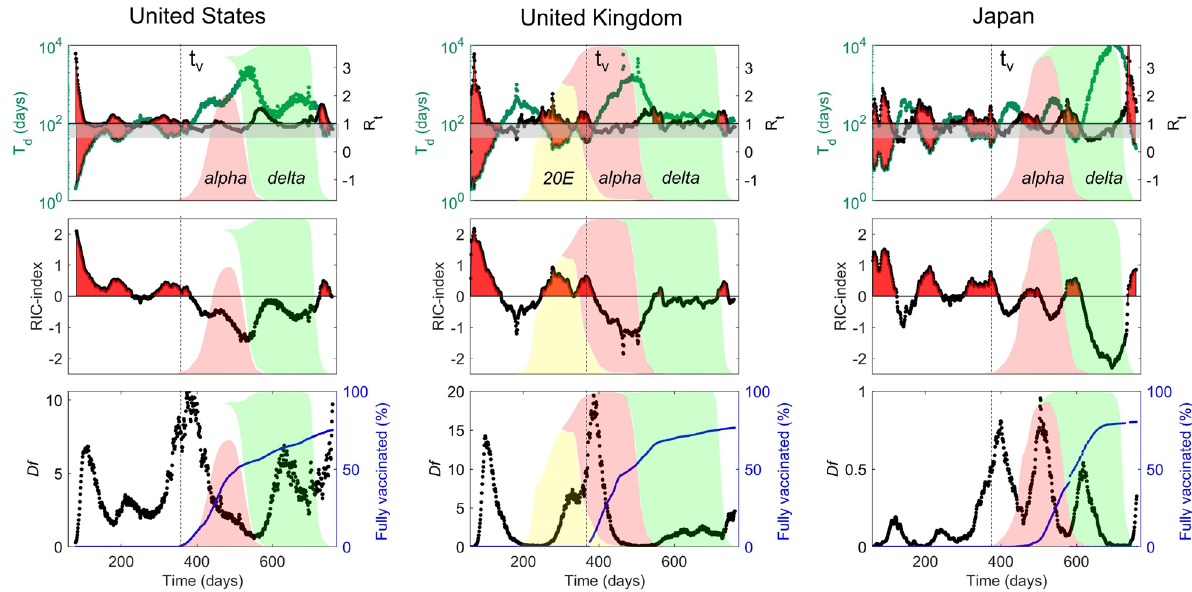
Figure 2. Epidemic spreading from 15/03/2020 to 28/01/2022 in United States, United Kingdom and Japan as described by T d , R t , RIC-index and daily fatalities per million populations ( Df ). The upper panels show plots of the time dependent doubling time 21 , T d , (green dots) and of the reproductive rate R t (black dots). The red areas are the supercritical phases that correspond to T d < 50 and R t > 1. The gray shaded stripe represents the critical crossover from the supercritical to the subcritical phase with T d > 100 and R t < 1. The three middle panels report the evolution of the RIC index where the horizontal black line separates the supercritical RIC index > 0 and the subcritical regime RIC index < 0. In the three lower panels we show the number of daily new deaths (Df) and the percentage of fully vaccinated people. In all panels the vertical dashed black line at t = t v = 350 (15/12/2020) indicates the beginning of the vaccination campaign. We show also the intervals associated with the recurrent waves of the different coronavirus variants (colored areas) indicating the proportion of total number of sequences, over time, that fall into defined variant groups. The top of the colored areas on the Y-axis correspond to ’1’. Sequence counts are binned into 2-week intervals. In the white area before the vaccination campaign the prevalent variant is the Wuhan virus strain. After t v the European 20E, Alpha , and Delta variants are reported. Finally, the last Omicron spreads in the white regions after the Delta light green